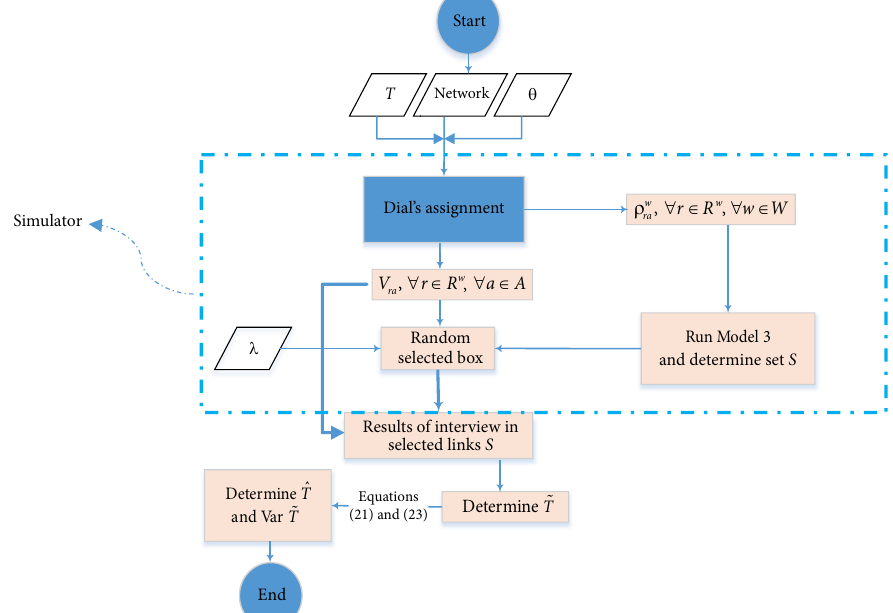
Figure 4. Flowchart of the proposed